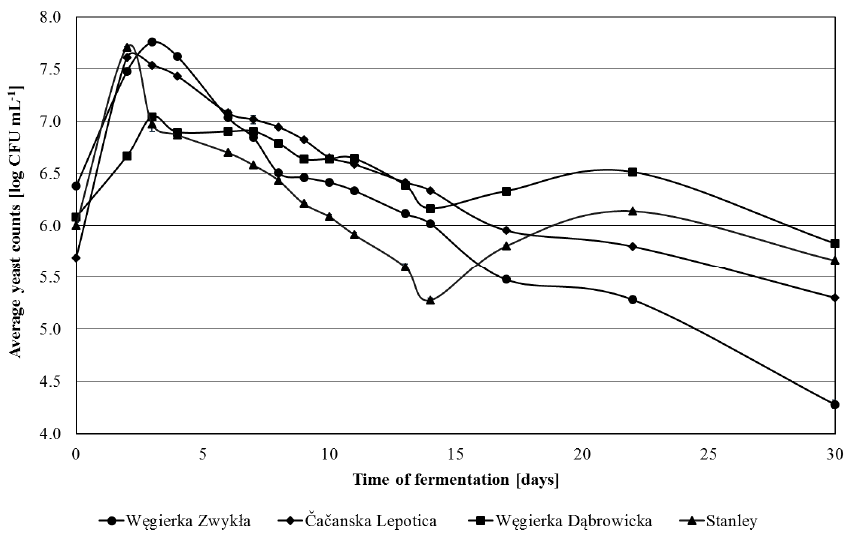
Figure 1. Total counts of yeasts 2012 season in the course of fermentation, n = 3, STD < 5%.